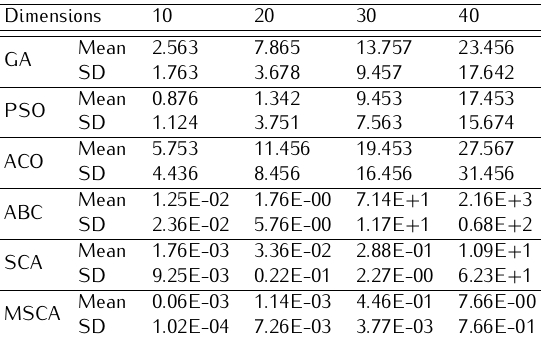
Table A.2. The results of GA, PSO, ACO, ABC, SCA and MSCA for Rosenbrock